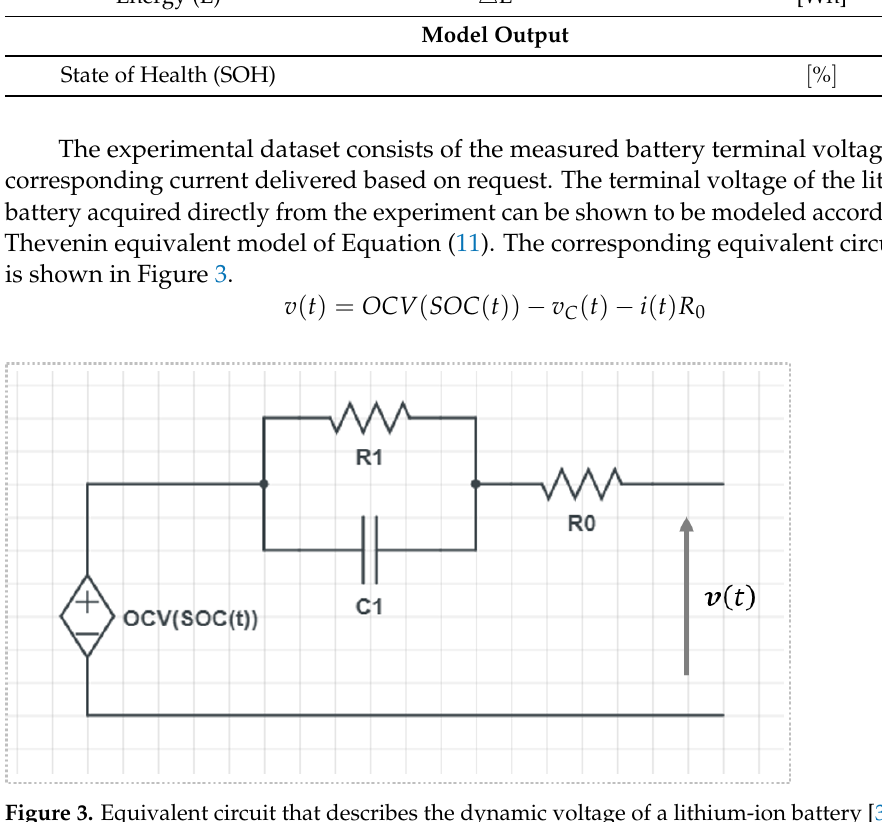
Figure 3. Equivalent circuit that describes the dynamic voltage of a lithium-ion battery